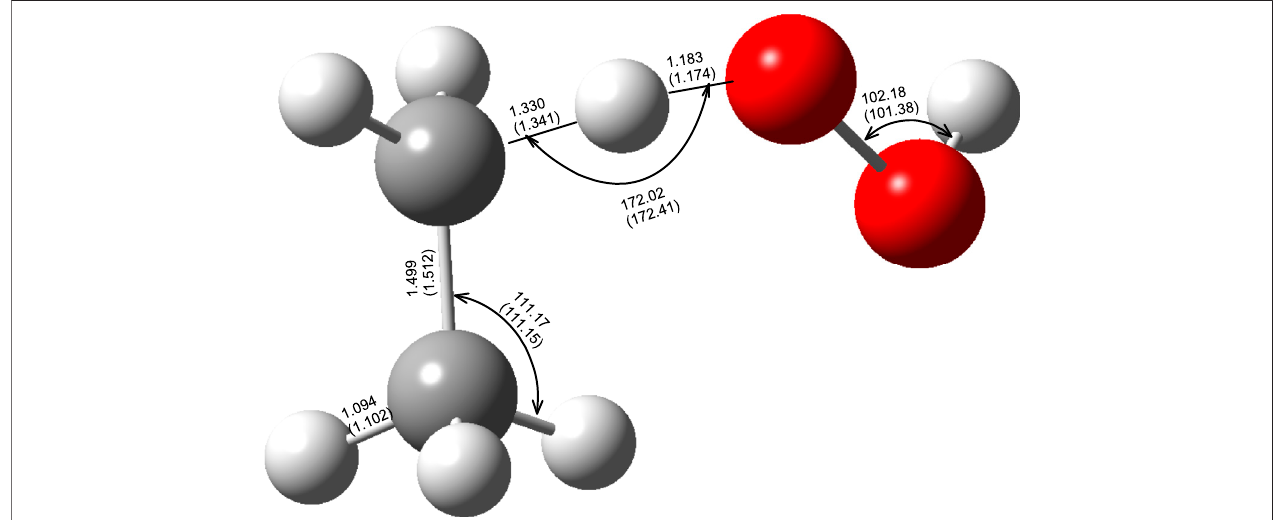
FIGURE 2 | Optimized geometries (distances in Å and angles in degrees) of the reactant transition state of the C 2 H 6 + · OOH → · C 2 H 5 + H 2 O 2 (R 1 ) reaction at the M06 – 2X/aug-cc-pVTZ and QCISD/aug-cc- pVDZ (numbers in parenthesis).